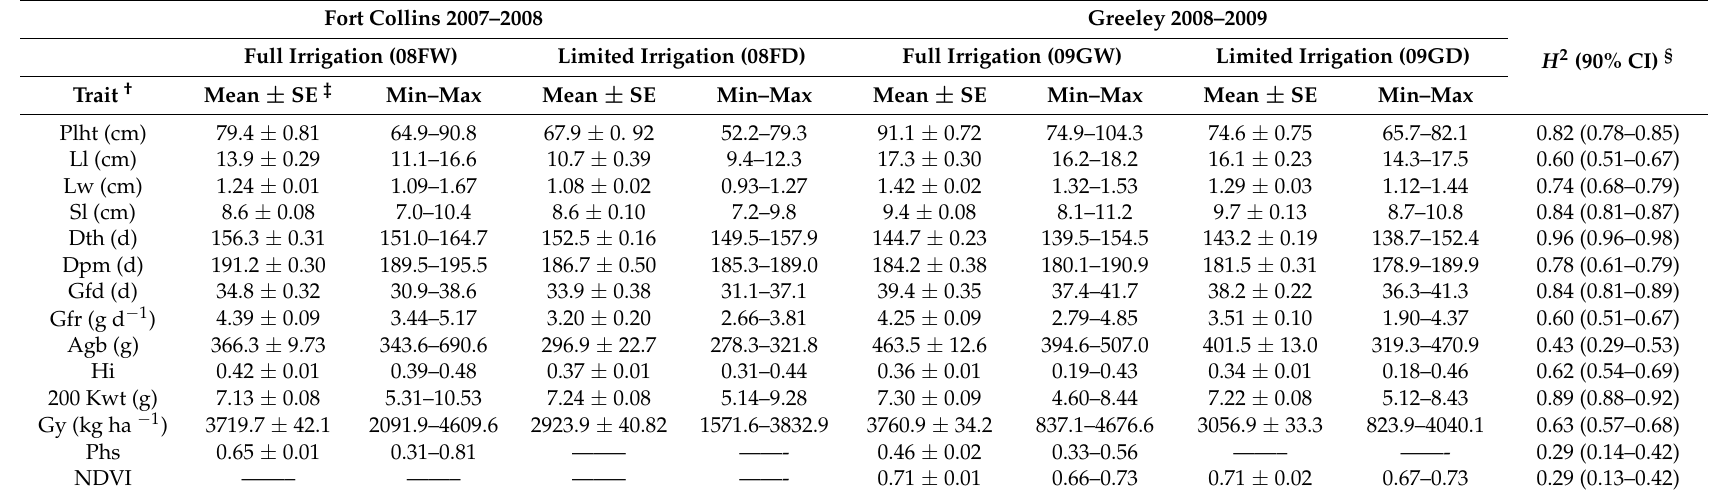
Table 1. Agronomic trait means and ranges and estimates of broad sense heritability for the CO940610/Platte population ( n = 185) at Fort Collins and Greeley, Colorado under two irrigation levels in the 2007–2008 and 2008–2009 growing